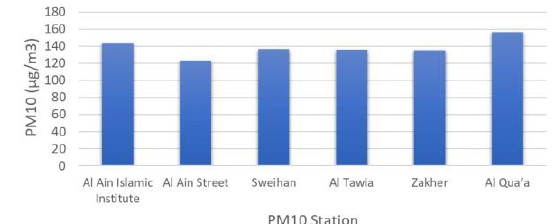
Figure 3 . Average daily concentrations of measured PM10.